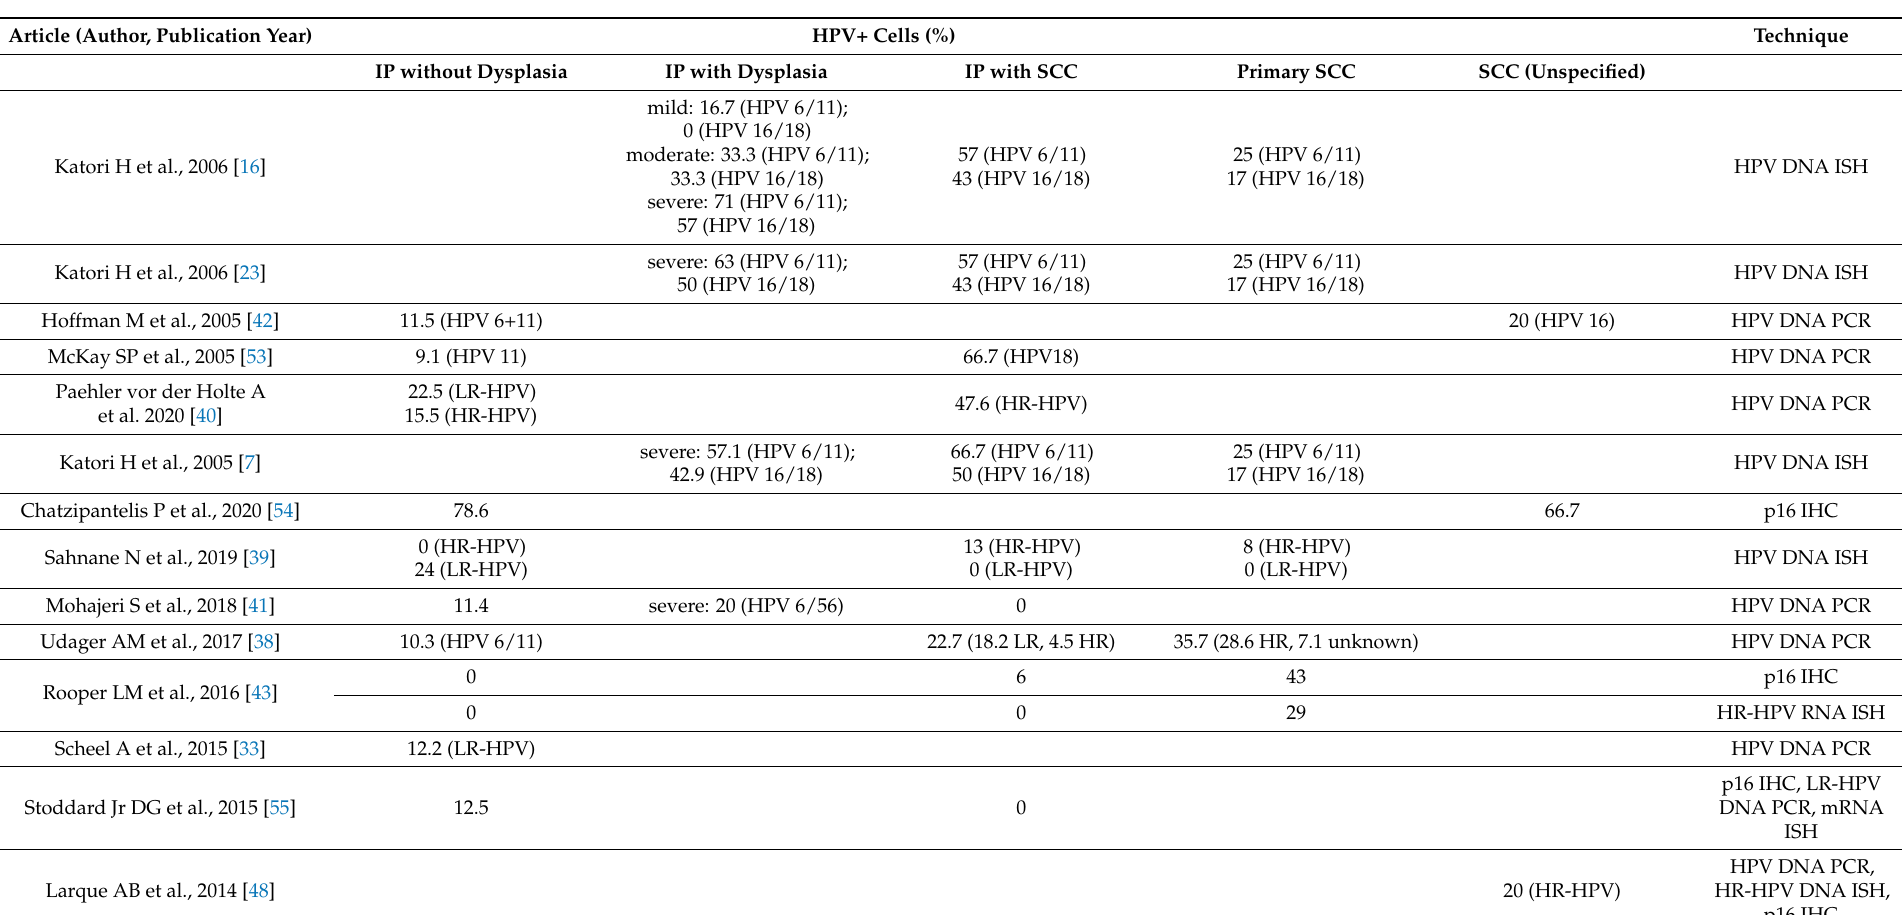
Table 2. HPV expression in sinonasal squamous cell carcinoma and precursors lesions. IP: inverted papilloma, ISH: in situ hybridization, PCR: polymerase